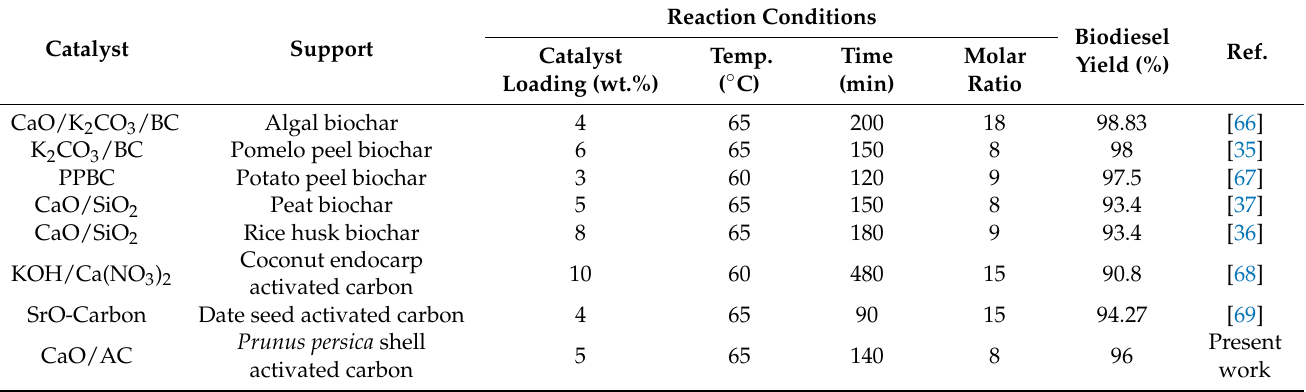
Table 5. Comparison of the catalytic performance of 20Ca/AC-650 and other carbon-based